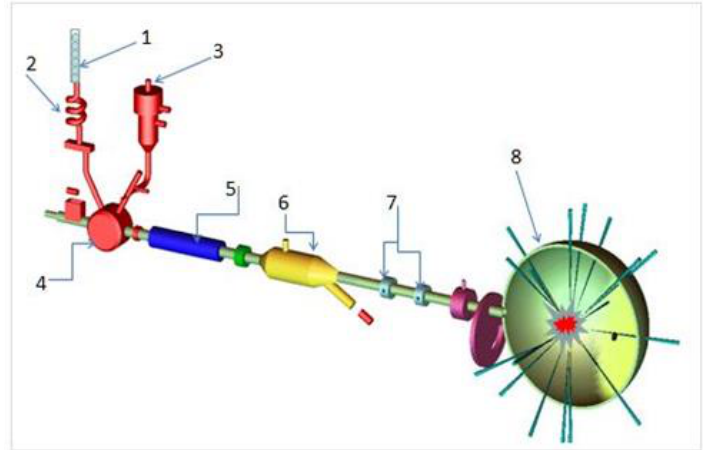
Figure 9. Schematic of the FST- transmission line (TL) operation: 1—SC, 2—FST-LM, 3—extruder for protective cover preparation, 4—FST-Projectile assembly module, 5—noncontact accelerator, 6—FST-Projectile separation module, 7—system for on-line target tracking and characterization,